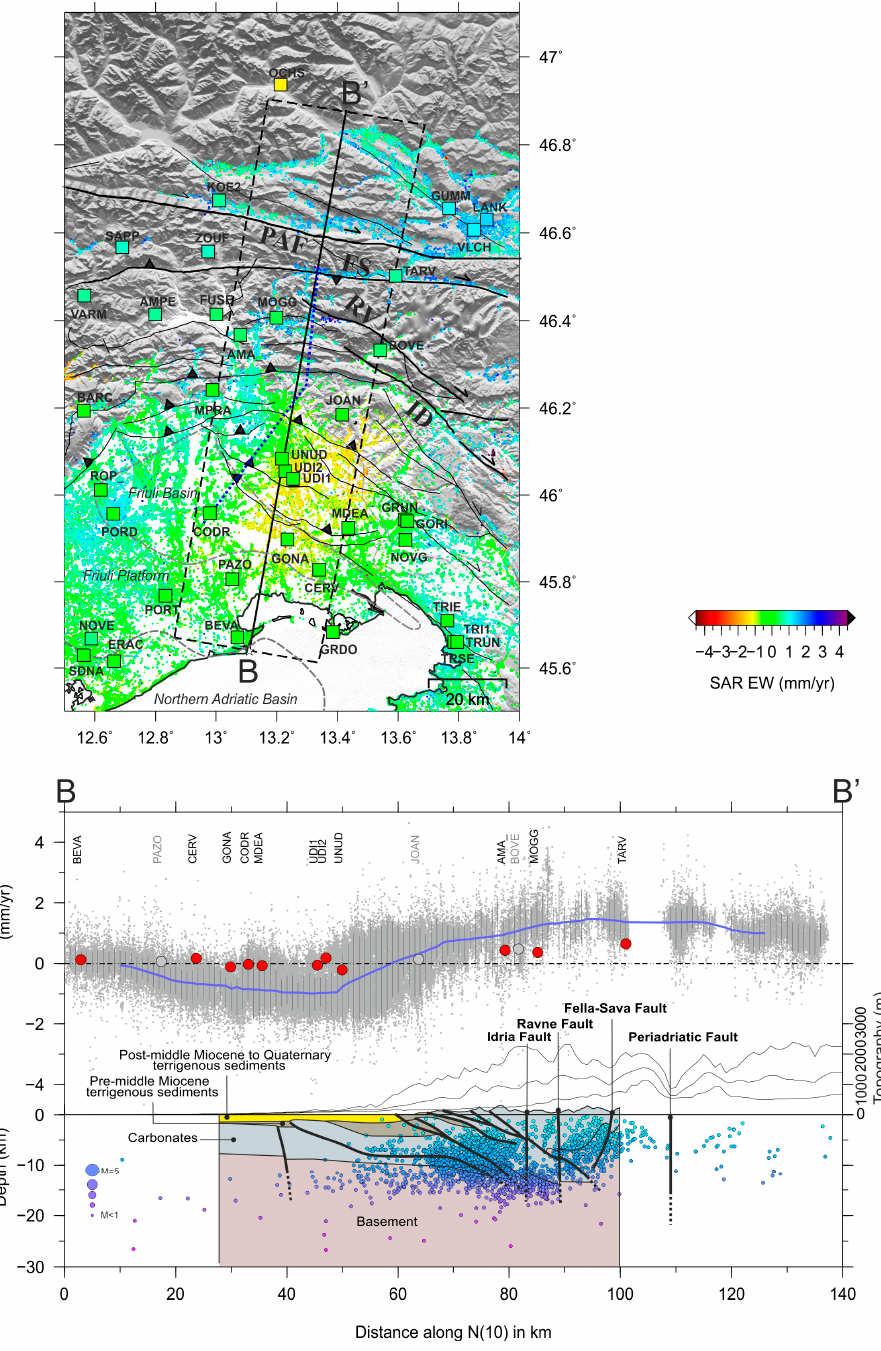
Figure 8. East–west velocity profile across the Alpine (Carnic and Julian Alps) and Dinaric system. Top : the map shows the east–west velocity values for each PS, while the colored squares indicate the east–west velocity of the GNSS stations, according to the InSAR multicolor scale on the right (red = westward; blue = eastward displacement). The blue dotted line represents the trace of the geological section reported below. The profile with a buffer of 20 km is 140 km long, and the white star indicates the starting point. Bottom : the plot shows the east–west SAR velocities (grey dots), whereas the blue line indicates the median value. The circles with relative uncertainties represent the east–west velocities of GNSS stations; specifically, the grey ones have not been used during the calibration. The geological section is modified from Merlini et al.